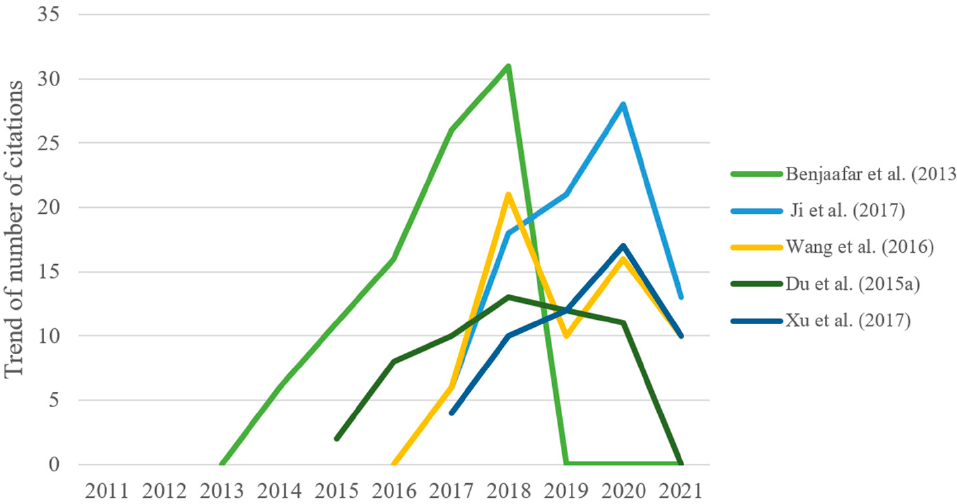
Figure 5. Citation history analysis of the top five co-citation documents.